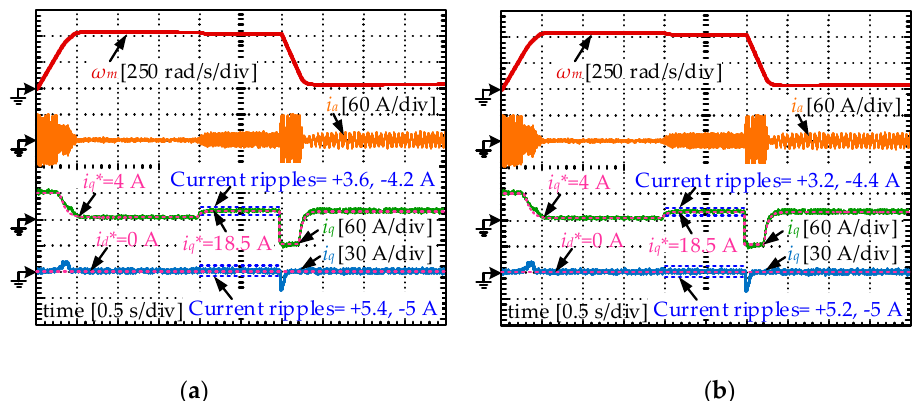
Figure 15. Experimental results of the proposed FCS-MPCC method under different resistance and inductance disturbances: ( a ) L 0 = 0.5 L , ∆ L = 0.5 L , R s0 = 0.5 R s , ∆ R s = 0.5 R s ; ( b ) L 0 = 2 L , ∆ L = − L , R s0 = 5 R s , ∆ R s = − 4 R s .